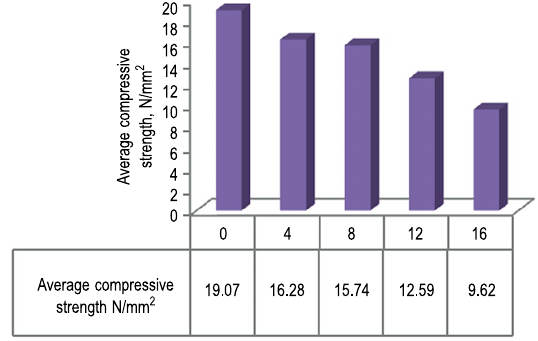
Fig. 4. The 28 days compressive strength result